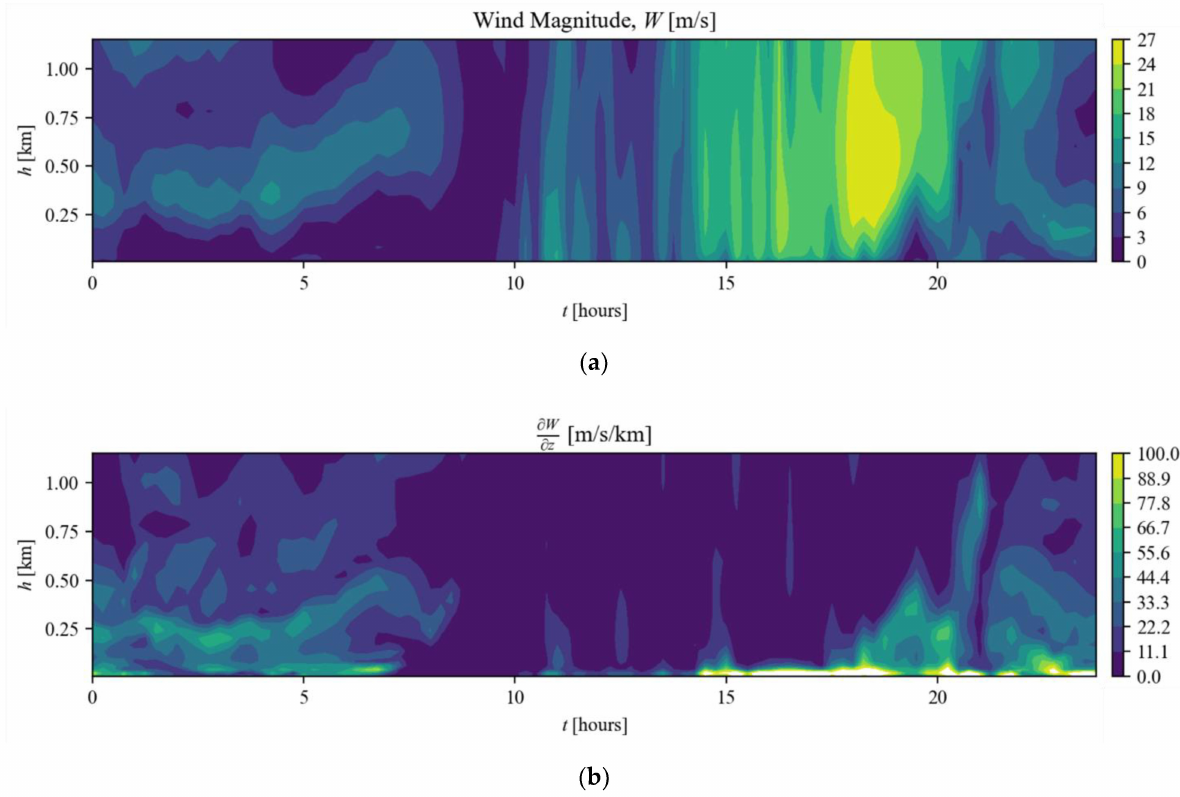
Figure 6. ( a ) Horizontal wind magnitude; ( b ) Vertical gradient of horizontal wind as a function of the local time and altitude from a MRAMS simulation at Jezero